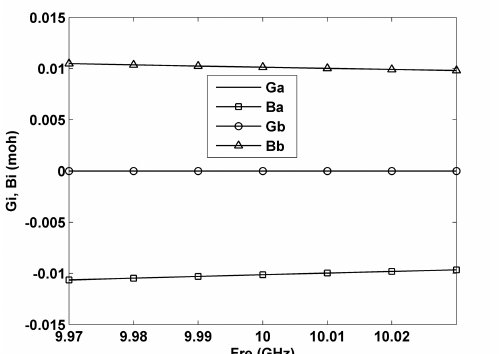
Figure 5. The equivalent circuit parameters for directional coupler with a=22.9mm, t=1mm and z 2 -z 1 =36mm. The circuit model of the directional coupler with lumped elements is shown in Fig. 6. Magnitudes of the elements have been shown in Figures 7 and 8.